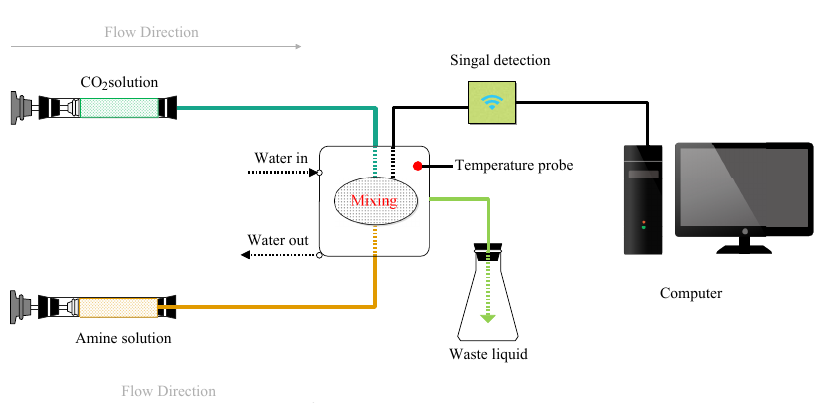
Figure 2. Schematic diagram of the experimental